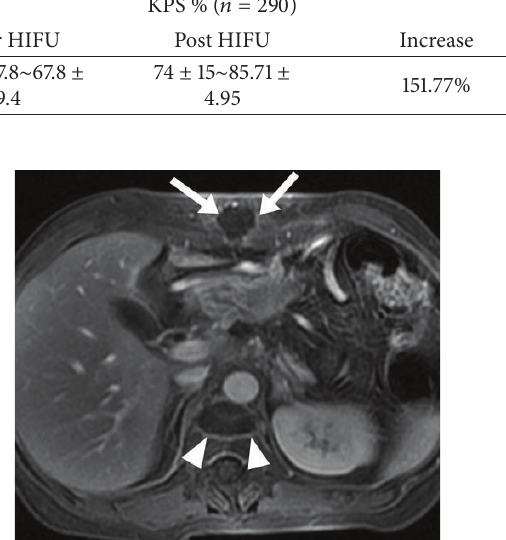
Figure 3: Large rim-enhancing areas of fat necrosis (arrow head) and vertebral body necrosis (arrow) along the ultrasound propa- gation path in a pancreatic cancer patient two weeks after HIFU ablation in fat-saturated T1-weighted magnetic resonant image after gadolinium infusion (used with permission